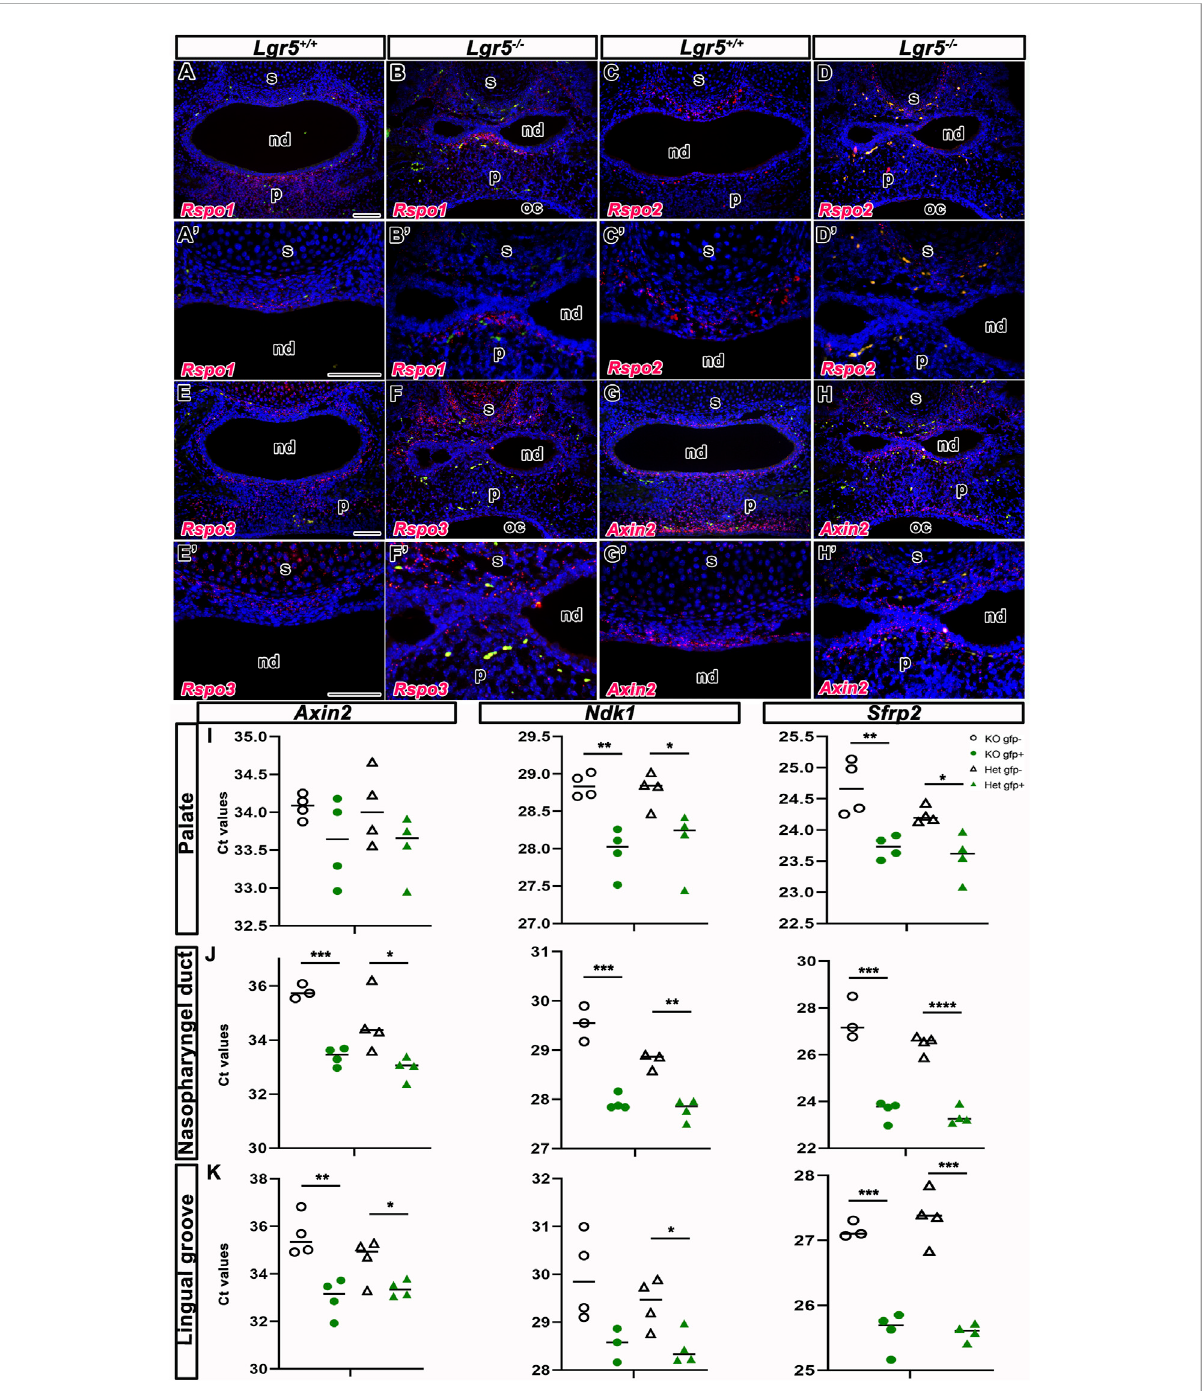
FIGURE 12 Wnt signaling in Lgr5 -de fi cient mice. RNAexpression ofthreeLGR5ligands — Rspo1,Rspo2 and Rspo3 and Wnttargetgene Axin2 in Lgr5 +/+ and Lgr5 − / − mice at E16.5. The expression of genes is labelled by red color. Erythrocytes, which are naturally auto fl uorescent, are labelled by greencolor. RNAexpressionof Rspo1 isobserved inthemesenchymesurroundingnasal septum and nasopharyngealduct. The signi fi cantexpression of Rspo1 is situated in palate (A,A´) of Lgr5 +/+ mice. The similar expression of Rspo1 is observed in Lgr5 − / − mice (B,B´) . Rspo2 is expressed also in the mesenchyme surrounding nasal septum in both WT embryo (C,C´) and Lgr5 -de fi cient mice (D,D´) . The expression of Rspo3 is situated in the mesenchyme around nasopharyngeal duct and surrounding nasal septum in Lgr5 +/+ mice (E,E´) and similar expression pattern of Rspo3 is found in Lgr5 − / − mice (F,F´) , but it seems to be more disperse in the mesenchyme of Lgr5 − / − embryo than Lgr5 +/+ embryo. Axin2 expression is situated in the mesenchyme surrounding nasopharyngeal duct and nasal septum in both WT (G,G´) and mutant embryos (H,H´) . (I-J) qPCR analyses of selected